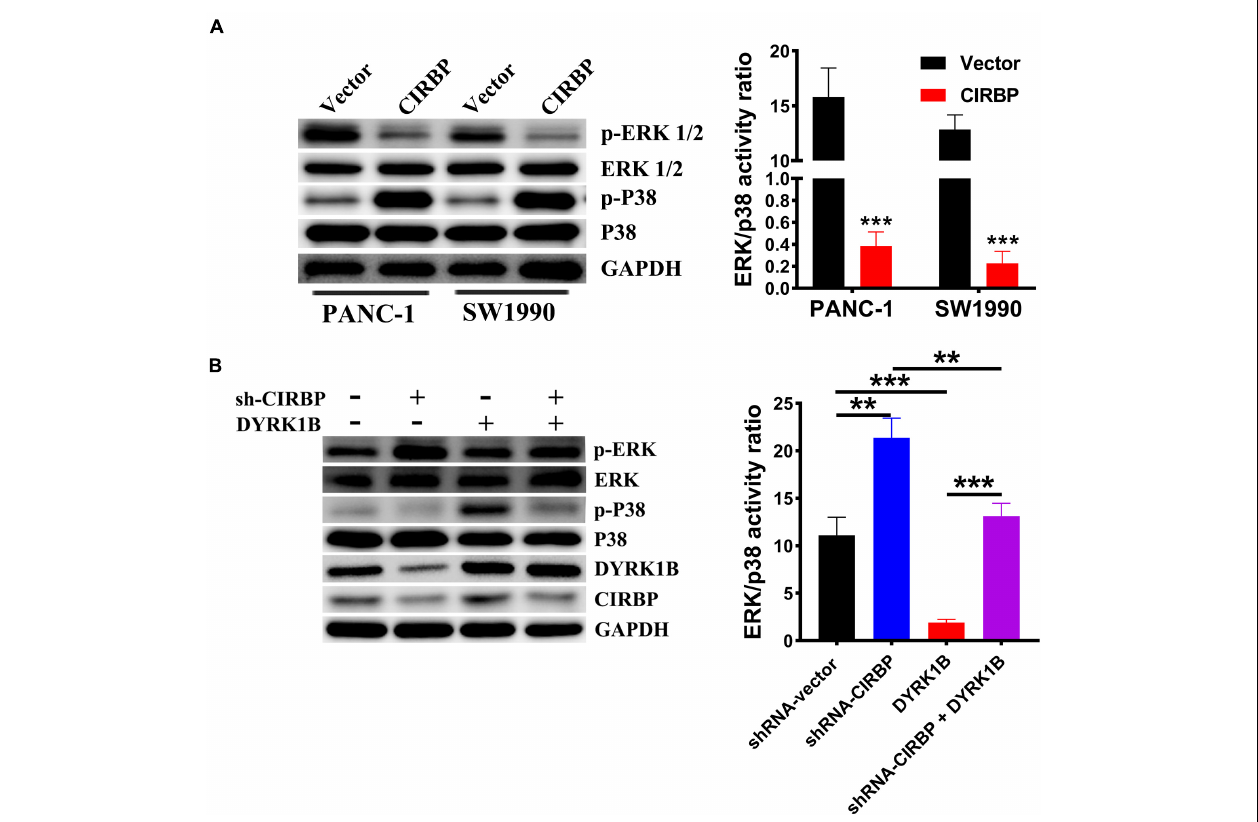
FIGURE 7 | CIRBP upregulates DYRK1B and decreases the ratios of p-ERK/p-P38. (A) Proteins in the mitogen-activated protein kinase (MAPK) family, including phosphorylated and total ERK1/2 and p38, were analyzed by Western blot, suggesting activation of ERK1/2 low and p38 high activity ratios by CIRBP in PANC-1 and SW1990 cells. (B) Western blot analysis showed that DYRK1B overexpression decreased the ratio of ERK/p38 in CIRBP sh#2 (sh-CIRBP)-transfected PANC-1 cells. The ratio of ERK/p38, expressed as the value of p-ERK to p-P38, which the value of phosphorylated ERK1/2 or p38 was standardized by total ERK1/2 or p38 before, respectively. GAPDH was used as a loading control. Data are presented as means ± SD. ** P < 0.01, *** P < 0.001, unpaired student’s t